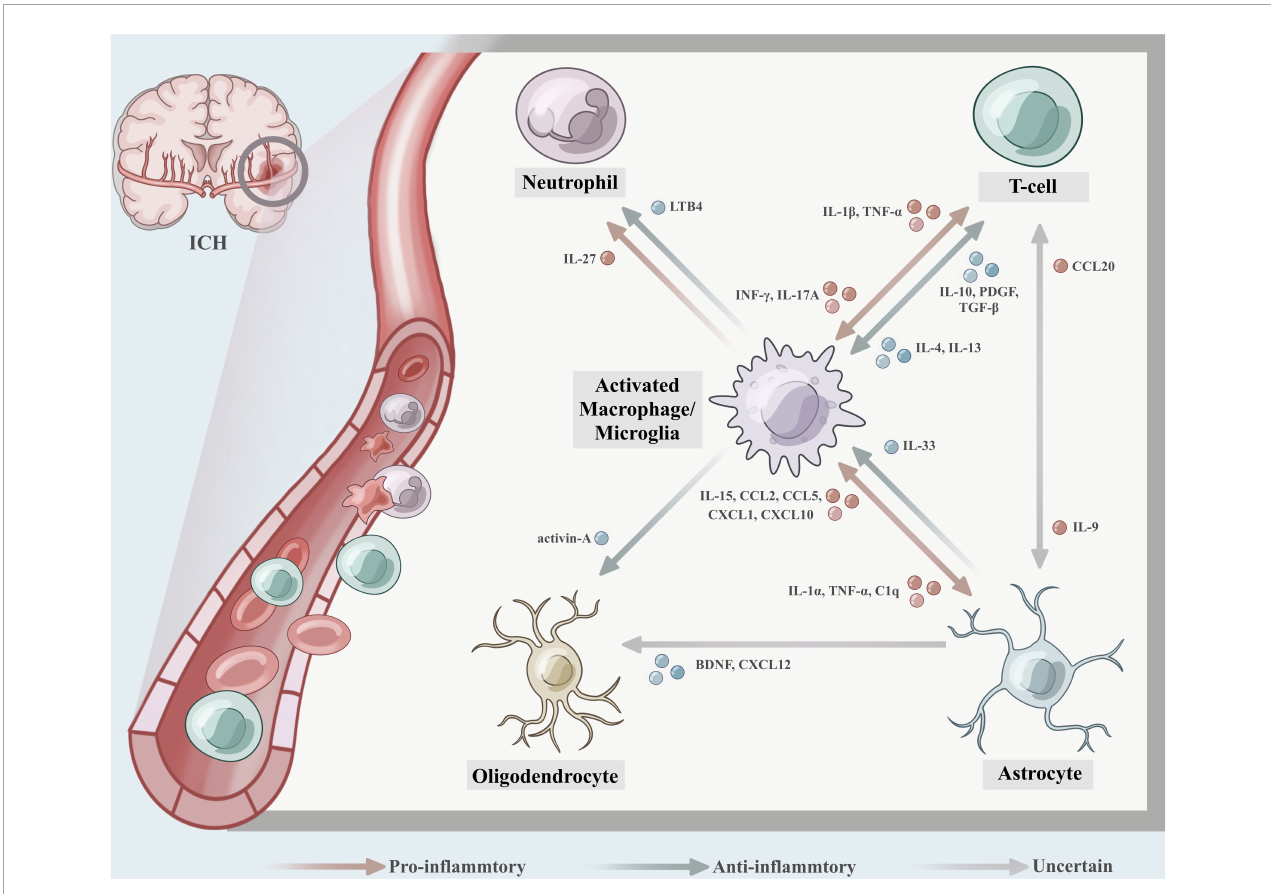
FIGURE2 The crosstalk between different immune cells after intracerebral hemorrhage (ICH). (1) Activated microglia were able to induce astrocyte conversion to A1 type by secreting IL-1 α , TNF, and C1q, promoting neuronal death and exacerbating the inflammatory injury, astrocytes express IL-15, CCL2, CCL5, CXCL1, and CXCL10, which enabled microglia to polarize toward pro-inflammatory phenotype. While astroglial-derived IL-33 promotes microglia synaptic phagocytosis and neural circuit development, which maintains synaptic homeostasis in the developing central nervous system. (2) Th1 cells secrete IFN- γ to promote macrophage to polarize toward M1, and the activated macrophages further secrete inflammatory factors IL-1 β and TNF- α , which cause aggregation of Th17 cells, exacerbating the inflammatory response and leading to tissue damage. IL-17A expressed on Th17 cells was detected to induce microglial activation and inflammatory responses in a mouse autologous blood model, while mediating autophagy of microglia. Th2-driven IL-4 and IL-13 promote macrophages to M2-type polarization, which secret IL-10, PDGF, and TGF- β contributing to collagen deposition and tissue healing. (3) M2 microglia/macrophage-derived activin-A boosts oligodendrocyte differentiation, and astrocyte-derived brain-derived neurotrophic factor (BDNF) contributes to the differentiation of oligodendrocyte progenitor cells (OPCs) into oligodendrocytes and may be an effective therapeutic target for the repair of white matter damage after ICH. (4) Leukotriene B4 (LTB4) derived from microglia causes neutrophils to migrate to the hematoma site and exacerbates the inflammatory damage effect, while microglia-derived IL-27 can mediate the functional regulation of neutrophils, inhibit the production of inflammatory factors by neutrophils, and reduce the formation of hematoma and edema. (5) IL-9 produced by Th cell subsets could exacerbate disease progression by inducing astrocytes to secrete